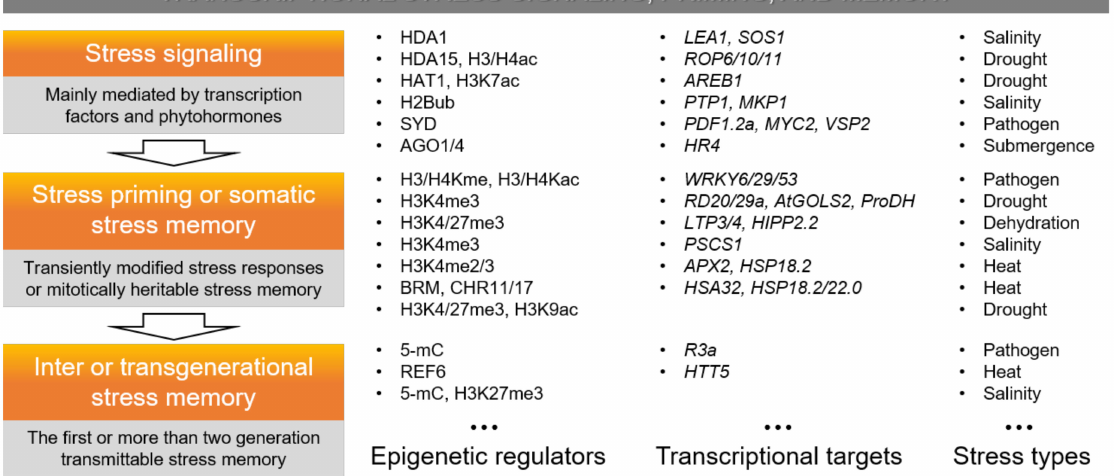
Figure 3. Chromatin-based transcriptional reprogramming for stress signaling, priming, and memory in plant stress response. Pivotal roles of epigenetic regulators or chromatin modifications in plant stress response are somewhat understood in association with transcriptional priming or memory but still remain unclear in heritable transcriptional reprogramming; therefore, they are to be further explored, particularly in relation to inter- or transgenerational stress